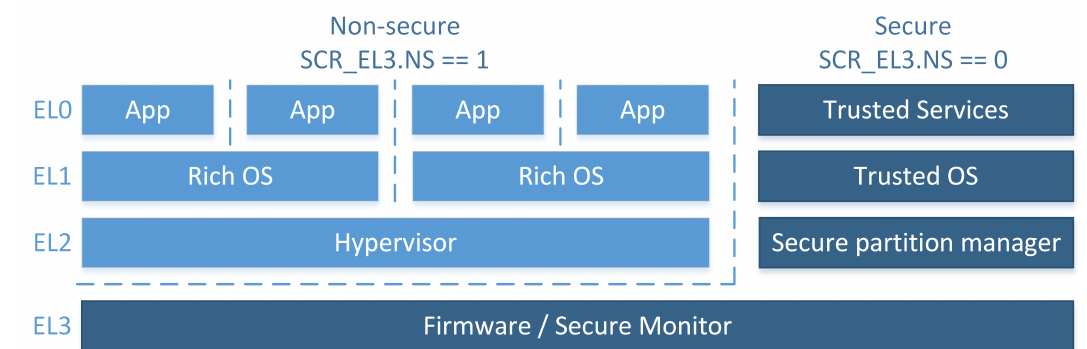
Figure 1. Concept of a TrustZone supported execution environment on software and firmware levels, based on [41]. The division between non-secure and secure worlds, as well as their construction with accentuated levels of operation, are presented. The SCR_EL3.NS is a register bit used to switch between the trusted and not trusted environments. The Secure Monitor, a special processor mode controlling the transition between secure and non-secure states, is presented as a common base for the